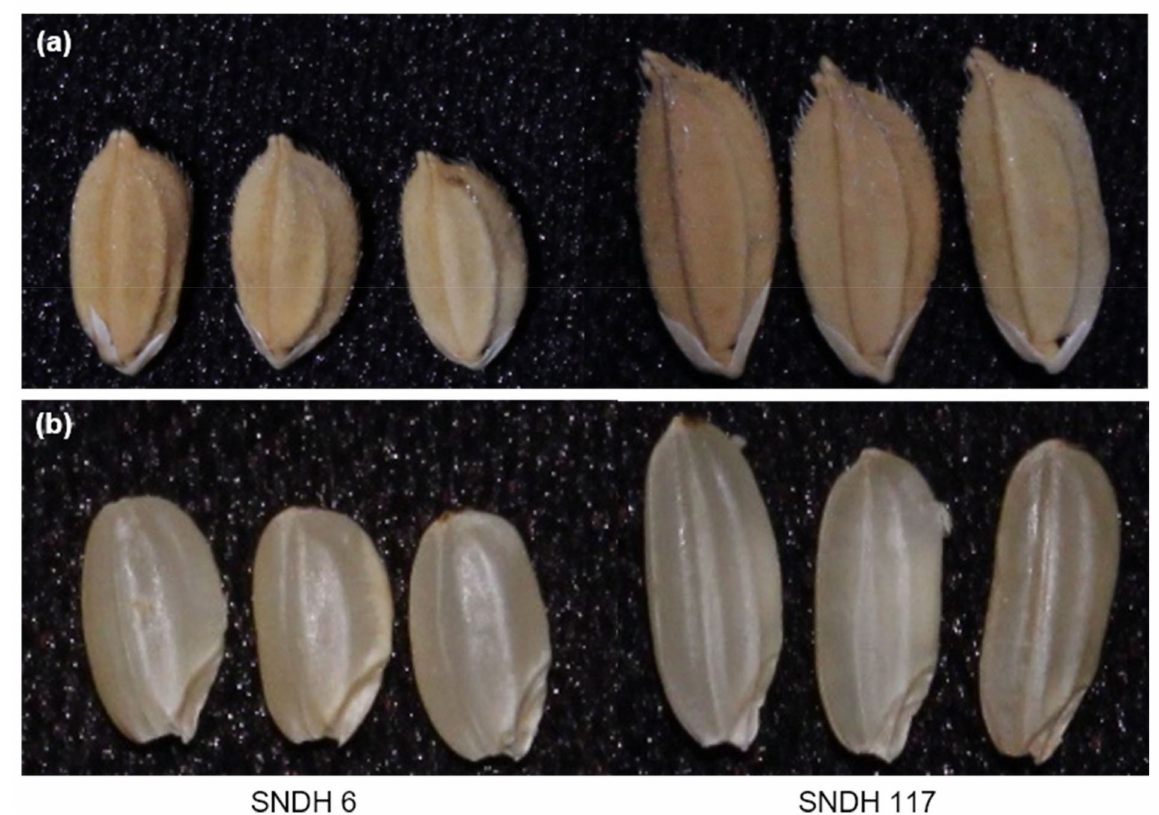
Figure 1. Mature paddy grains and brown rice gains of the SNDH 6 and SNDH 117 rice lines. Grain size varied in the SNDH (Samgang/Nagdong double haploid) line. The SNDH6 line had the smallest grain size, whereas SNDH117 had the largest grain size. When comparing the grain size before and after the chaff removal, the grain size of SNDH117 was the largest and the grain size of SNDH6 was the smallest. ( a ) Rough rice without removing the chaff. ( b ) Brown rice with chaff